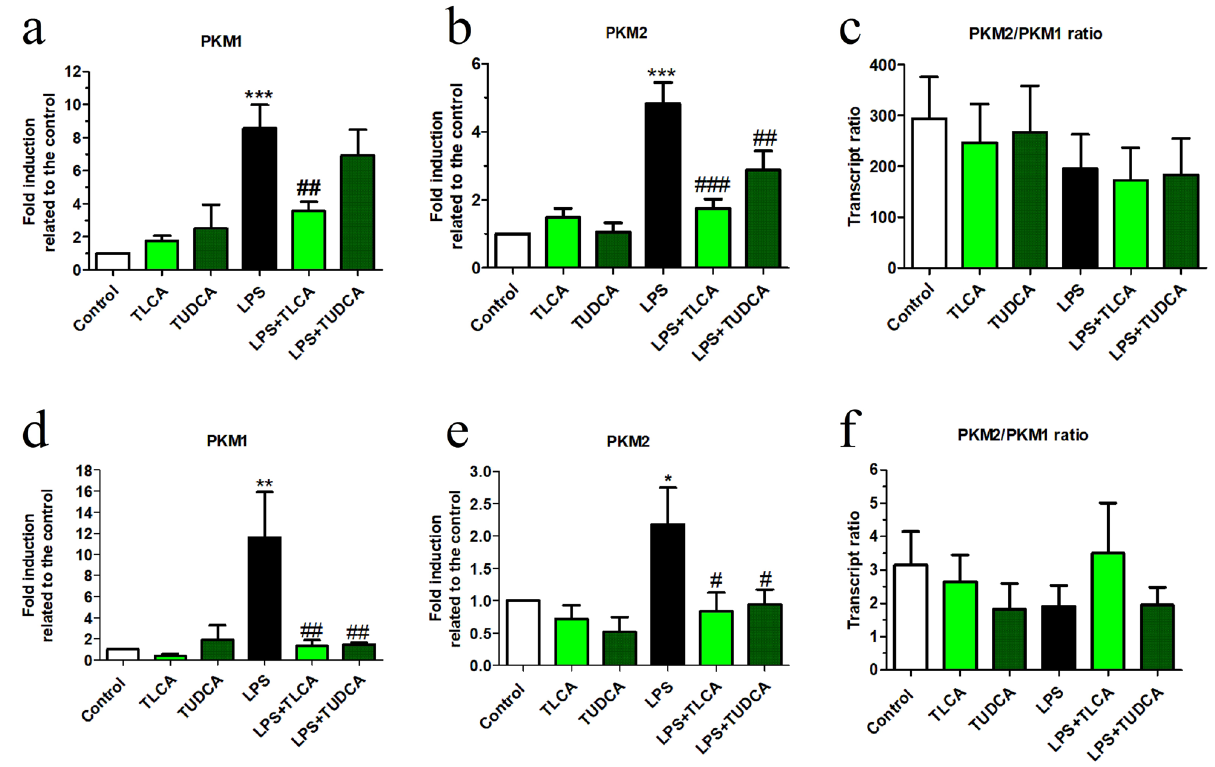
Figure 2. Treatment with bile acids inhibits LPS-induced PKM1 and PKM2 transcription in cell cultures. The mRNA expression for (a, c) PKM2 and (b, d) PKM1, and (e) PKM2/PKM1 transcript ratio was determined by qRT-PCR in microglia and in Raw264.7 cultures. Cells were preincubated with TLCA (40 μM), TUDCA (200 μM) for 2 h followed by LPS (10 ng/ml for microglia and 50 ng/ml for Raw264.7 respectively) was added for further 24 h. The expression of 36B4 for microglia or RPS29 for Raw264.7 cells respectively was used as a housekeeping gene to normalize the data. ANOVA revealed significant treatment effects on the transcription of PKM1 in (a) microglial cells [F(5, 28) = 9,3, p < 0.001] and (d) in Raw264.7 cells, [F(7, 21) = 4.7 p < 0.01] and PKM2 (b) in microglial cells [F(5, 29) = 13.7, p < 0.001] and (e) in Raw264.7 cells [F(5, 23) = 3.7, p < 0.05] respectively. Changes of PKM2/PKM1 ratio in (c) microglial cells and (f) Raw264.7 cells were not statistically significant. Results of Dunnett’s post hoc tests are indicated as in Fig. 1 (* vs. control, # vs. LPS, n ≥ 3 independent